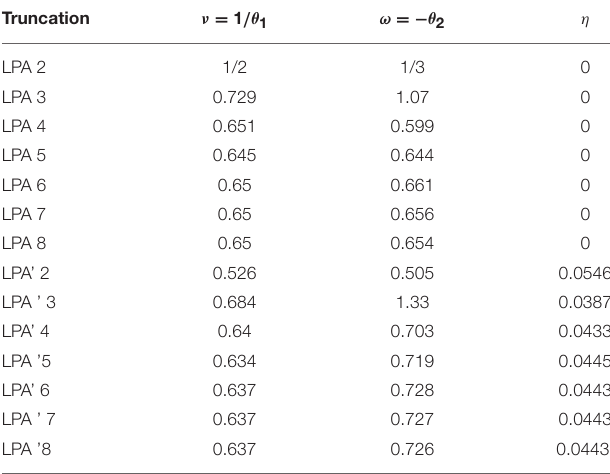
numericalevaluationoffixed-pointvaluesandcriticalexponentsrequiresabasicnumerical